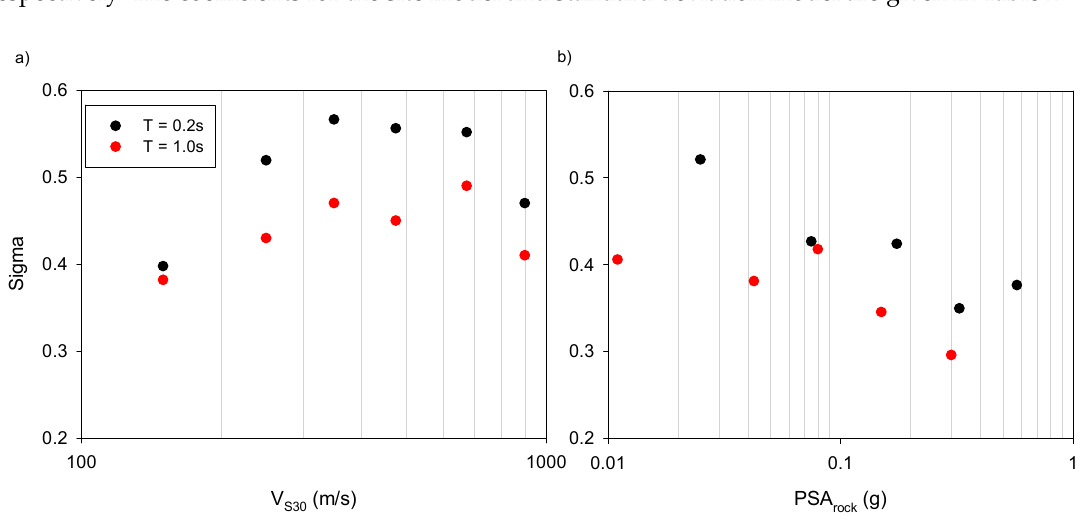
Figure 4. Variability of site amplification for T = 0.2 s and 1 s ( a ) for site bins ( b ) PSA rock bins. The input rock motion bins for T = 0.2 s are: very weak motion ( PSA rock < 0.05 g), weak motion (0.05 ≤ PSA rock < 0.15 g), moderate motion (0.15 ≤ PSA rock < 0.45 g), strong motion (0.45 ≤ PSA rock < 0.75 g), and very strong motion ( PSA rock ≥ 0.75 g). For T = 1.0 s they are: very weak motion ( PSA rock < 0.01 g), weak motion (0.01 < PSA rock < 0.05 g), moderate motion (0.05 < PSA rock < 0.10 g), strong motion (0.10 < PSA rock < 0.20 g), and very strong motion ( PSA rock > 0.20 g).